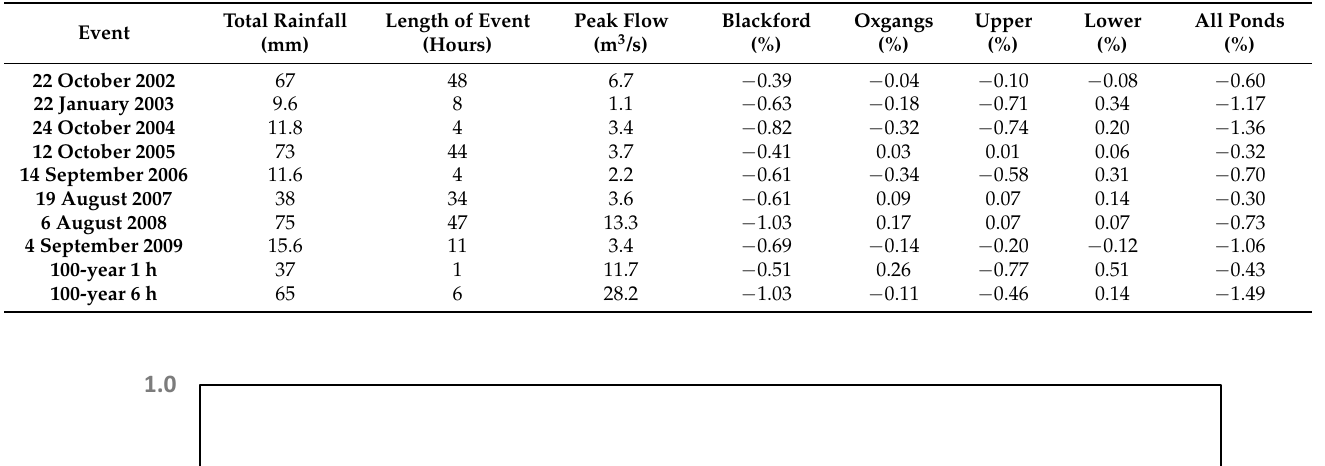
Table 4. The change in flow peak at the catchment outlet compared to the baseline run for the four individual ponds and with all the ponds incorporated into the model. This is for the eight measured events that produce annual maximum discharges and the two design events.